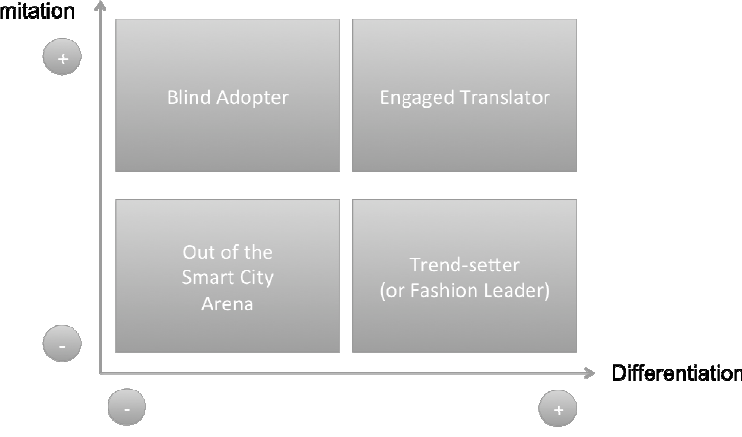
Figure 1: Smart City (Brand) Strategy:The Role of Fashion in City